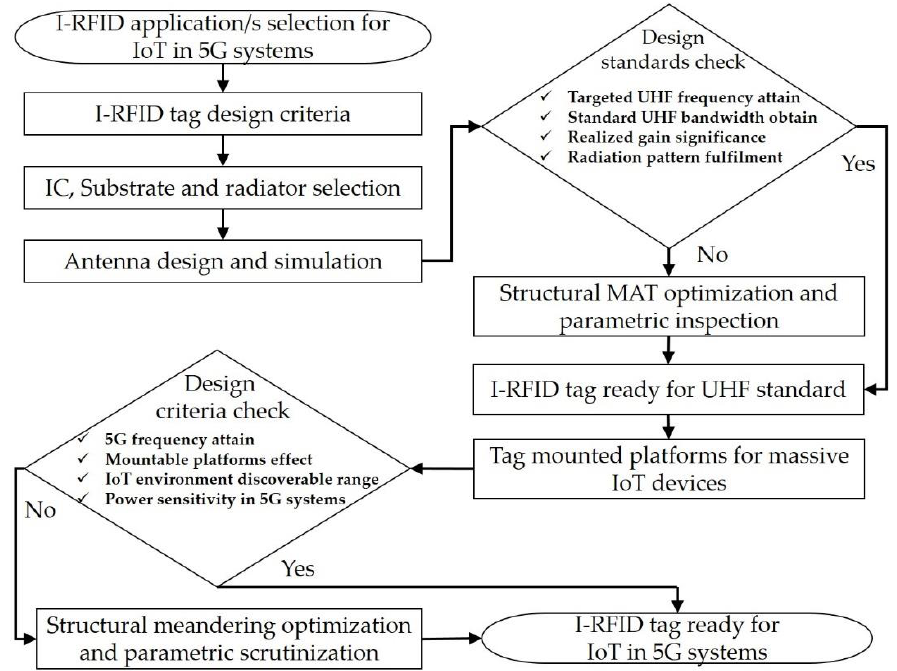
Figure 3. Flow chart of design process for I-RFID UHF tags for 5G IoT systems.